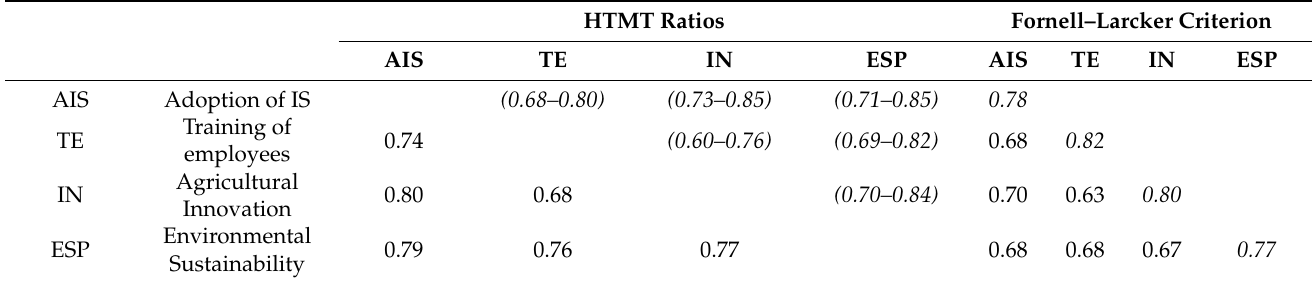
Table 4. Discriminant validity.